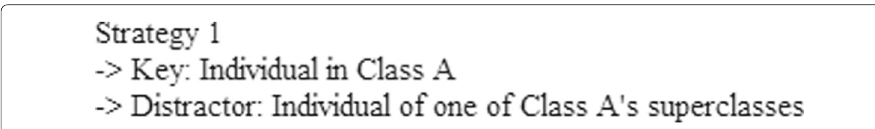
Fig. 1 An example of a Class-based